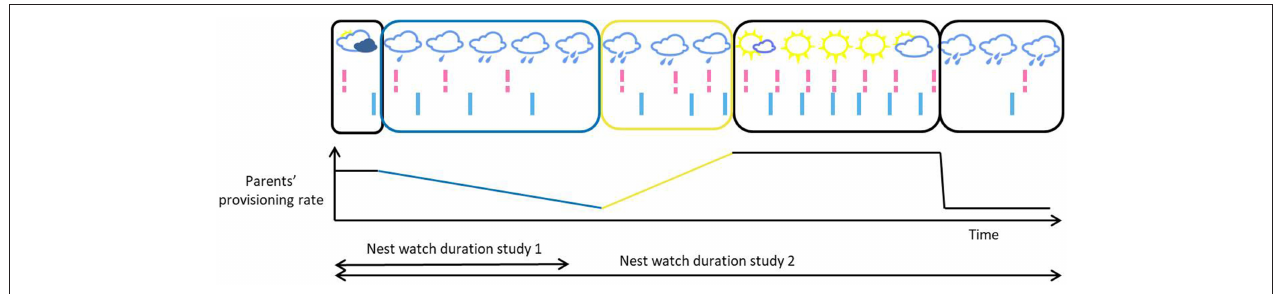
FIGURE 1 | Illustrative timeline of provisioning visits, with each bar representing a visit [female and male visits, in pink (dashed bar) and light blue (solid bar), respectively], and as a function of weather conditions. In this example, both parents have similar provisioning rates at any time, and their provisioning rates fluctuate simultaneously as a function of the environmental conditions. In blue is represented a period of gradual slowdown in provisioning visits, and in yellow a gradual but more sudden increase in the parents’ provisioning rates. In these periods, we can see a directional temporal autocorrelation of the interval length within each individual. The correlation between the pair members’ change in provisioning rate, which may be due to the environment, creates patterns of alternation. Depending on when the observation of the nest was made and the duration of that observation, the observer may capture a single directional change in the provisioning rates of the parents, or multiple directional changes in opposite directions and of different lengths (blue vs. yellow rectangles and